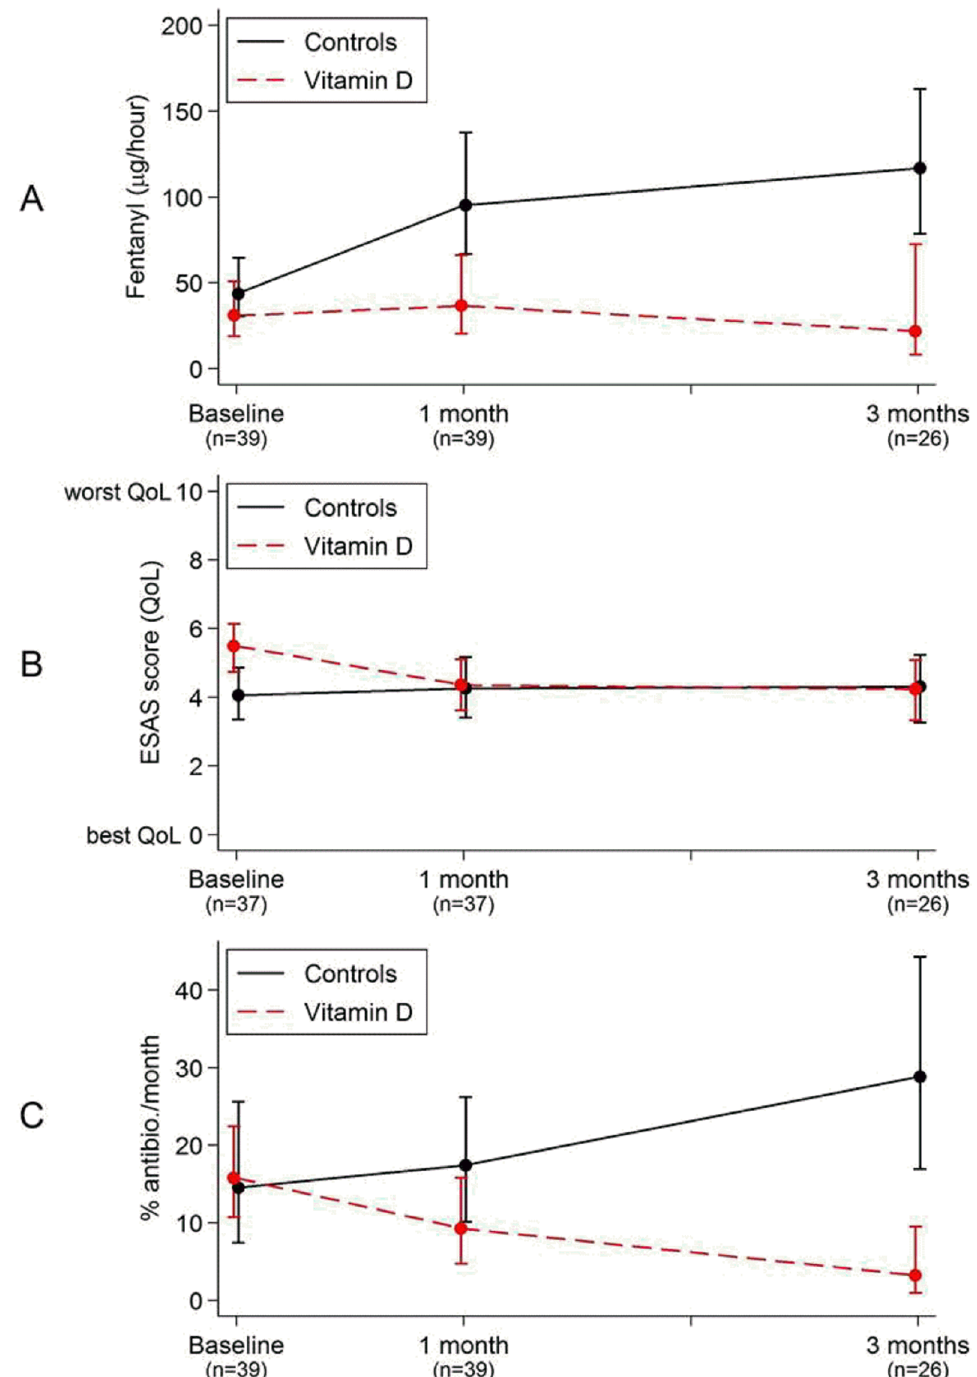
Fig 2. Differences in opioid dose ( μ g fentanyl/h) (A), Quality of Life (according to ESAS-assessment)(B) and antibiotic consumption (% of days with antibiotic the month before) (C) between 39 vitamin D treated palliative cancer patients and 39 matched controls. Points show mean values and bars show 95% CI. There was a significantdifference in fentanyl dose betweenthe groups as soon as 1 month after treatment and in antibiotic consumptions after 3